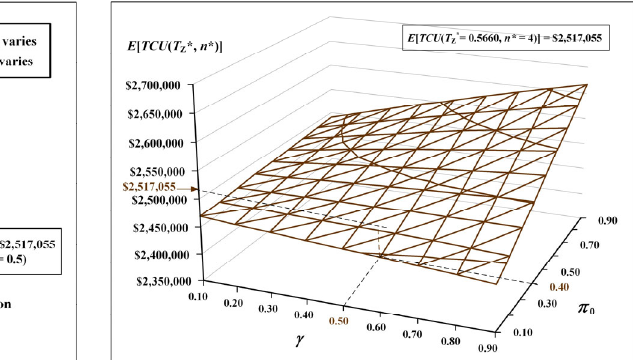
Fig. 14. E [ TCU ( T Z *, n *)]’s performance regarding the utilization-reduction options